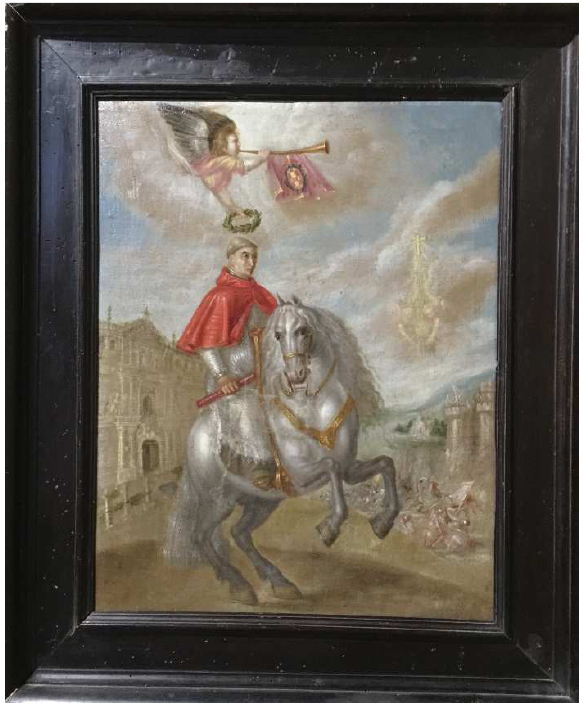
Figure 6: The Cardinal Cisneros riding a horse, between the University of Alcala facade and the Oran Castle. Parish Church,